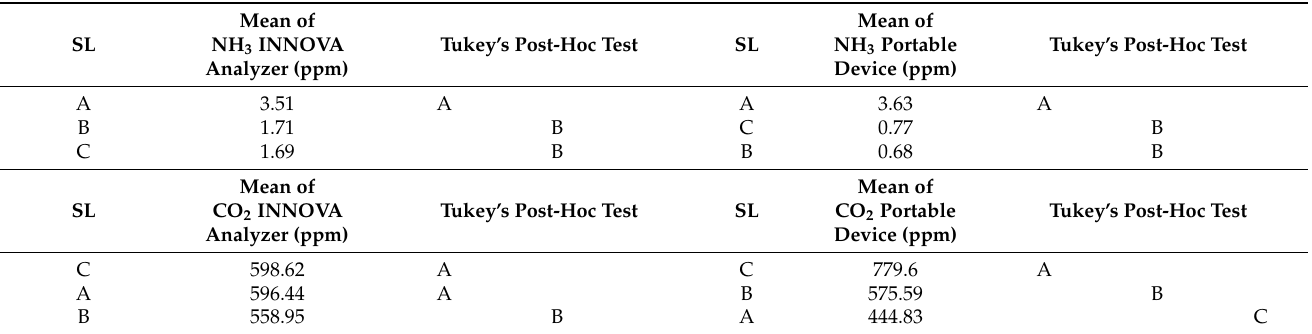
Table 1. Results of the ANOVA ( p < 0.05) carried out for gas concentrations of NH 3 and CO 2 at three groups of sampling locations (i.e., SLA, SLB, and SLC) for each gas.